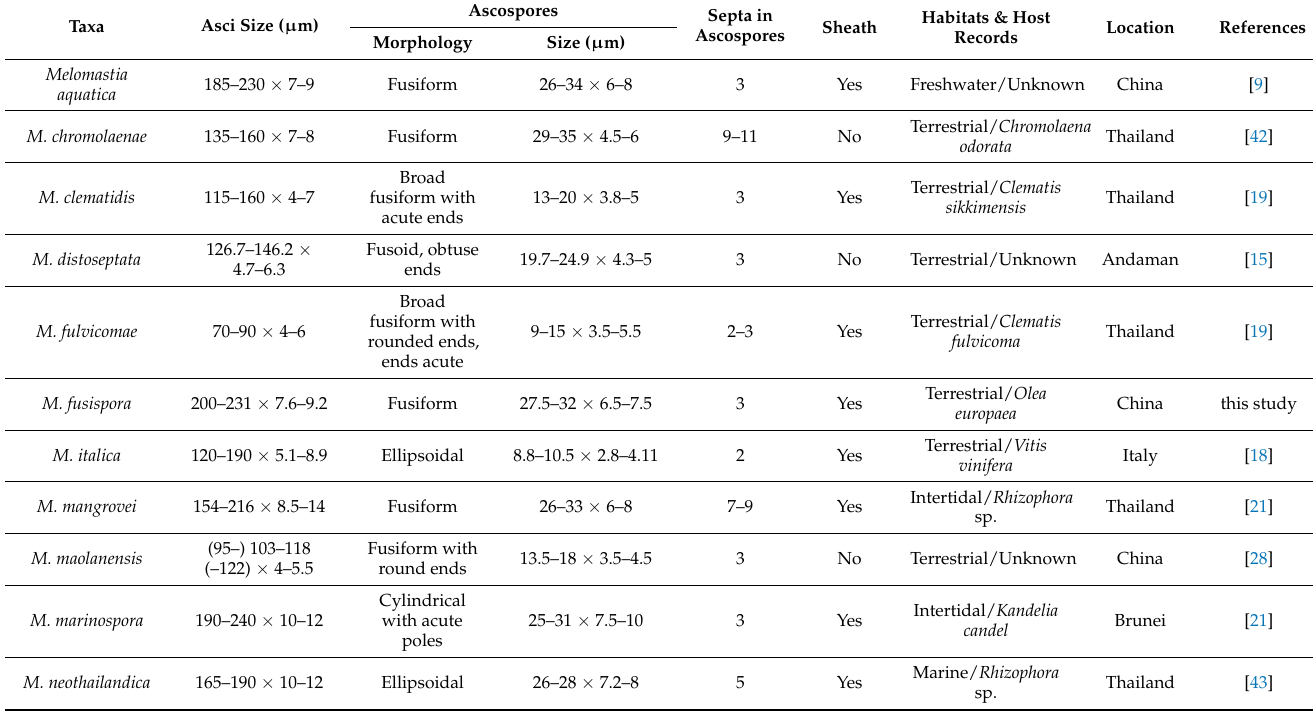
Table 2. Synopsis of morphological characteristics, habitats and hosts compared across Melomastia